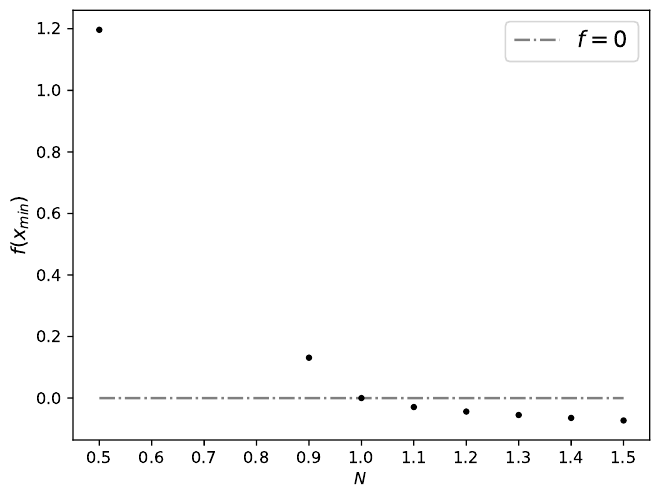
Figure 9: Value of the transformed navigator (5) at its minimum, for N between 0.5 and